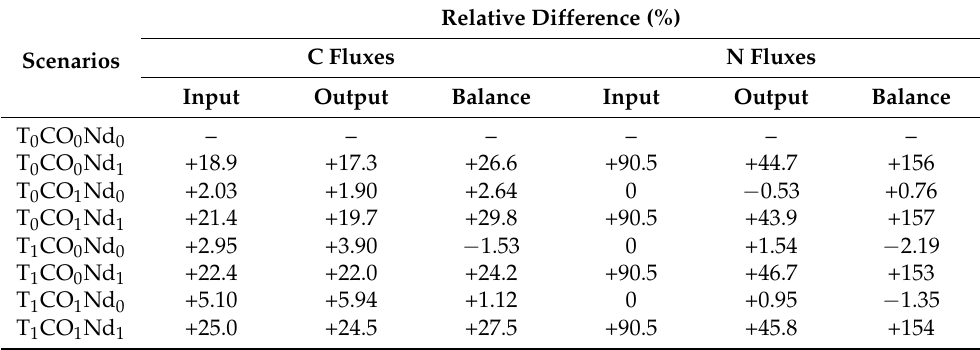
Table 2. The relative difference in the C and N fluxes during 1973–2020 across the South Korean forests as a result of an increased level of temperature, CO 2 concentration, and N deposition. Abbreviations of scenarios are found in Table